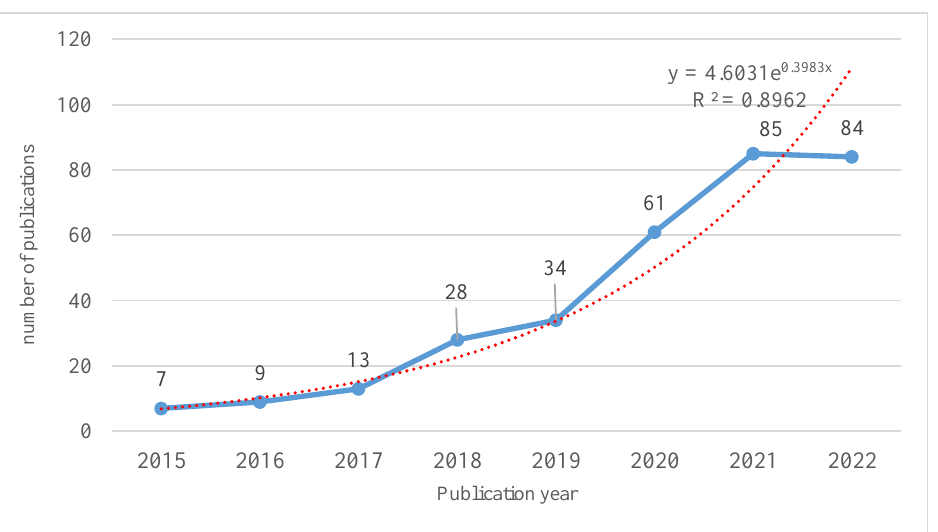
Figure 2. Number and trend of Building Information Modeling (BIM) and Internet of Things (IoT) related papers published from year 2015 to 2022 in the Web of Science core collection (WoSc) database (generated by the authors).